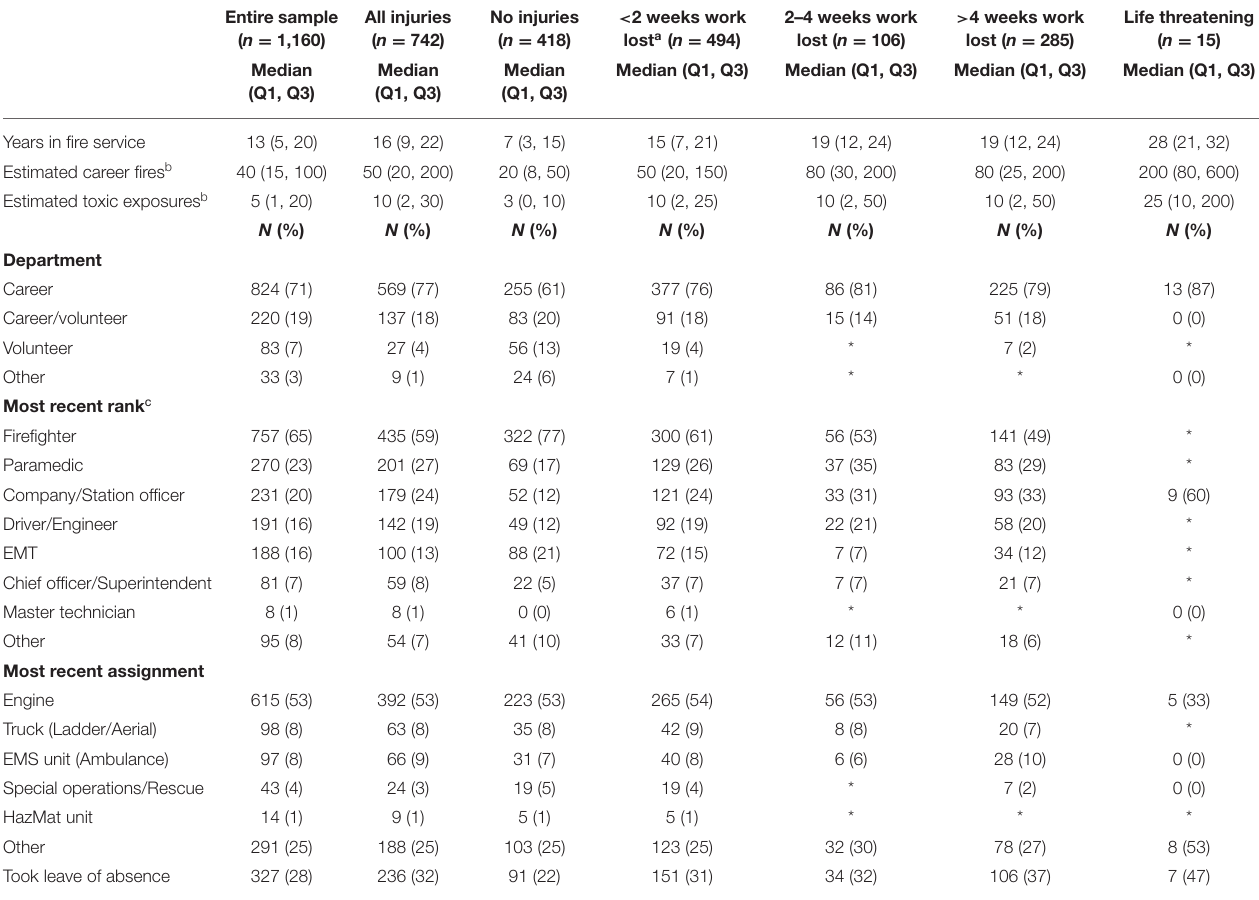
TABLE 2 | Firefighting experience of active female firefighter survey respondents in the US and Canada, by injury severity as measured by time of work